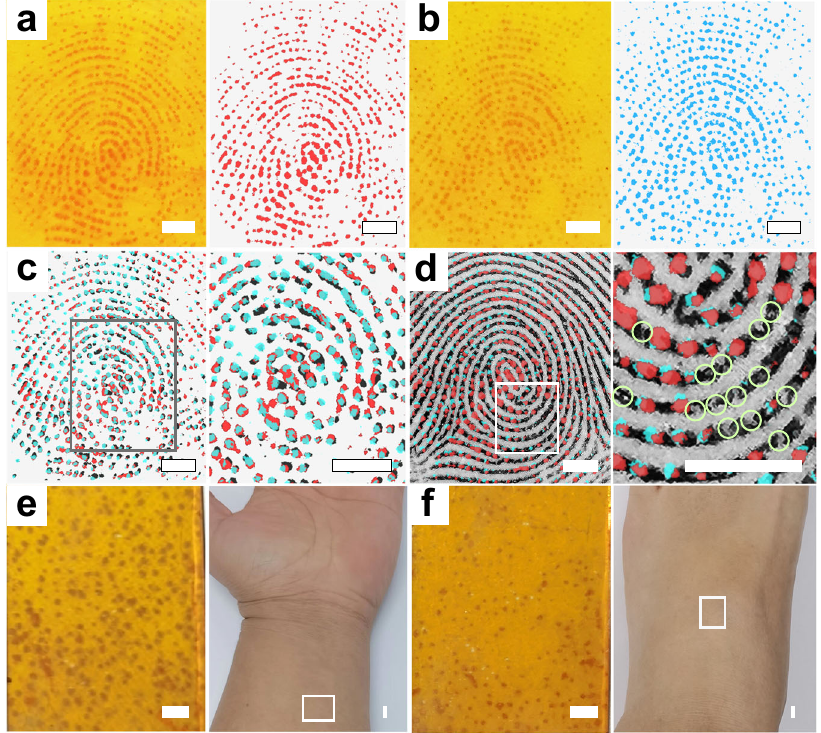
Fig. 5 | Sweat pore images collected by COF TPDA-TFPy fi lms. a , b Picture of 2 independentsweatporedistributionimagesand extractedsweatporedistribution images on 2 individual COF TPDA-TFPy fi lms from the same donor (Taken with a smartphone) c Superimposed images of 3 sweat pore images. d Superimposed imageofsweatporedistributionimagesonagraphite fi